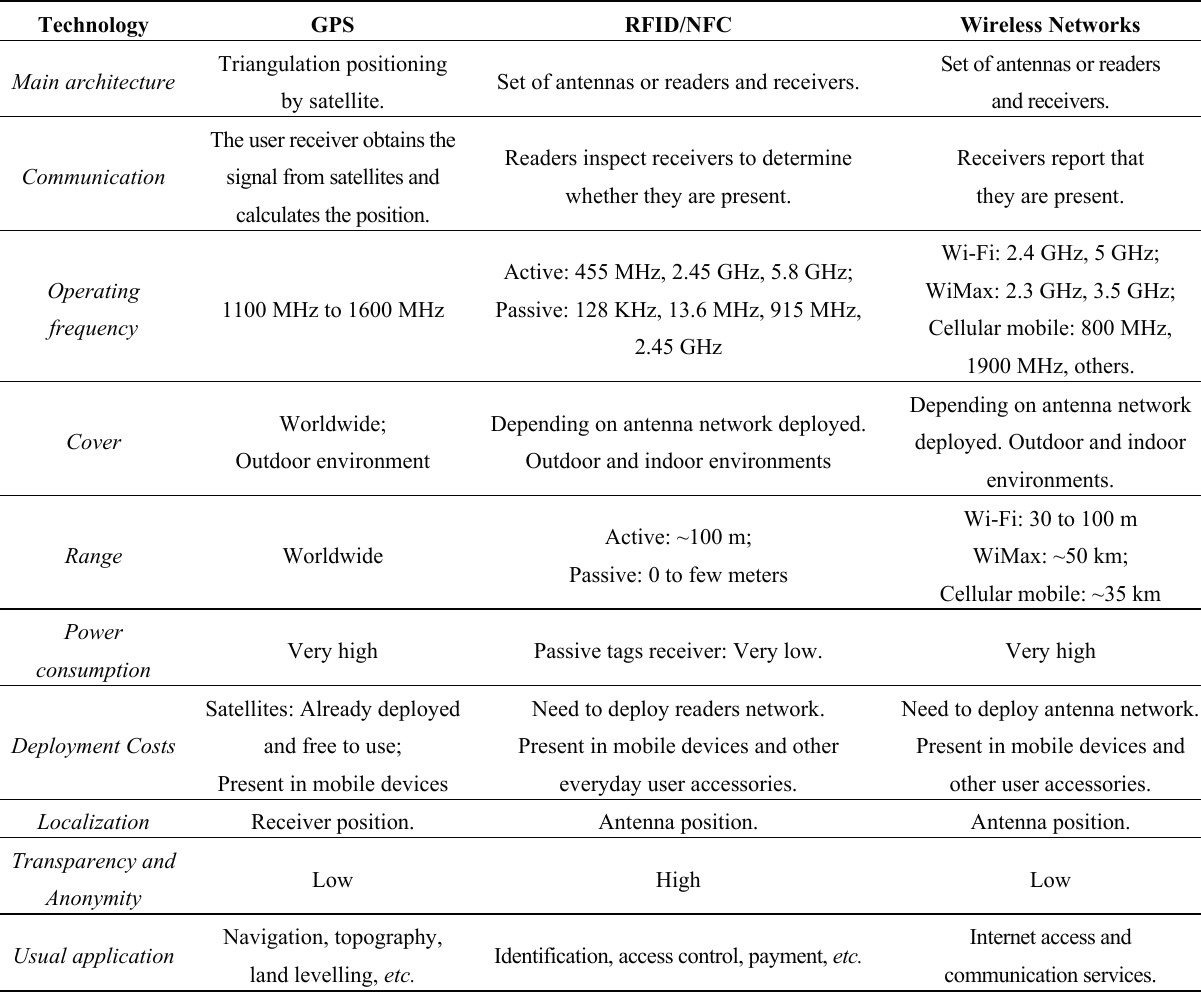
Table 2. Main features of communication